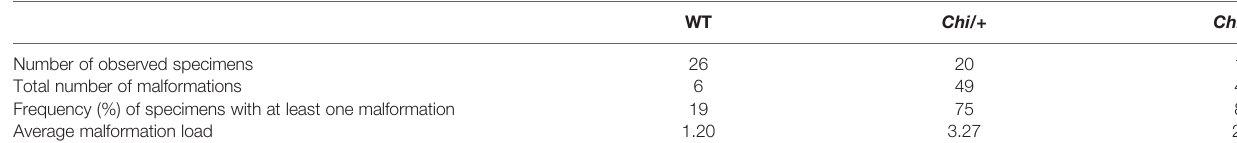
TABLE 1 | General metrics for the analysis of vertebral column malformations in WT, Chi/+ and Chi/+ LP